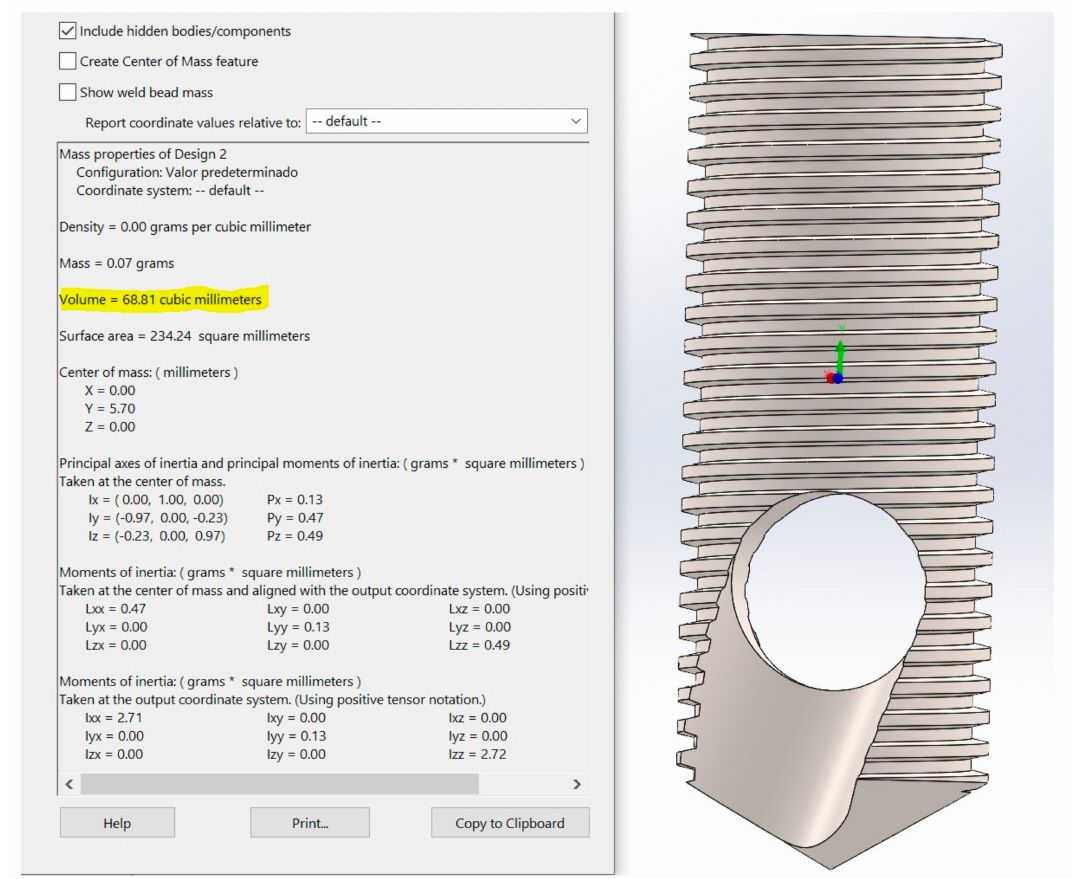
Figure 3. Final model with new biomechanism with a volume equal to 68.81 mm 3 .